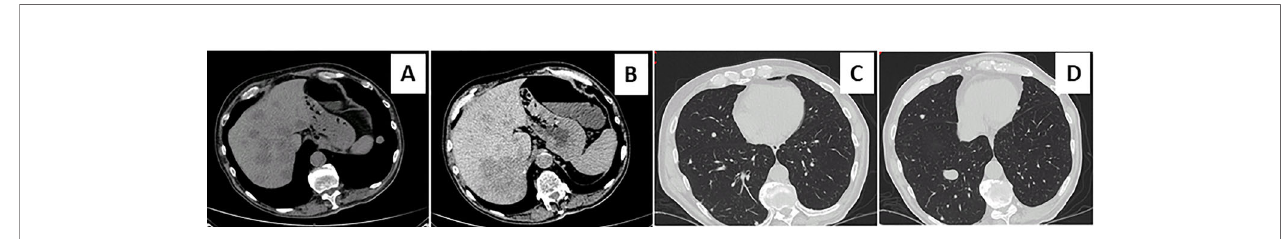
FIGURE 3 | Metastatic diffusion at chest and hepatic computed tomography scan. Contrast-enhanced abdominal and chest computed tomography scan showed the appearance of multiple metastatic pulmonary and hepatic nodules (A –